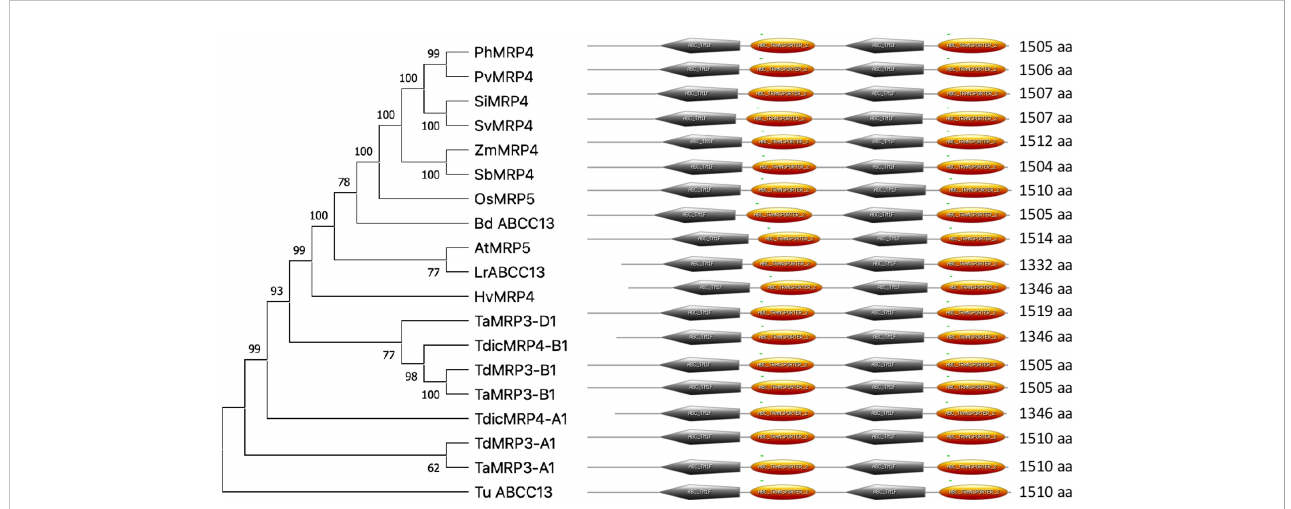
FIGURE 1 Phylogenetic tree of the ABCC multidrug resistance-associated protein (ABCC-MRP) in different plant species. Td: Triticum turgidum ssp durum MRP3- A1 (SVEVO PLATINUM SEQUENCE), MRP3-B (VEVO PLATINUM SEQUENCE), Ta: Triticum aestivum MRP3-A (XP_044384038 _TraesCS5A02G512500), MRP3-B (XP_044371728 TraesCS4B02G343800), MRP3-D (XP_044377018_TraesCS4D02G339000); Tu: Triticum urartu ABCC13 XP_048531007.1 ; Tdic: Triticum dicoc coides MRP4-A (XP_037437166.1), MRP4-B (XP_037426738.1); Hv: Hordeum vulgare MRP4 (XP 044983147.1); Bd: Brachypodium distachyon ABCC13 (XP_003558836.1); Zm: Zea mays MRP4 (EF586878); Sb: Sorghum bicolor MRP4 (XP 002468528.2); Pah: Panicum hallii MRP4 (XP 025794868.1); Pav: Panicum virgatum MRP4 (XP_039780041.1); Si: Setaria italica MRP4 (XP 004985744.1); Os: Oryza sativa Japonica group MRP5 (XP 015630971.1); At: Arabidopsis thaliana MRP5 (AT1G04120.1); Sv: Setaria viridis MRP4 (XP_034572896.1); Lr: Lolium rigidum ABCC13 like (XP_047089394.1). The tree constructed by the Neighbor-joining (NJ) method with pairwise deletion option and p-distance matrix in MEGA XI (Tamura et al., 2021). Bootstrap values (1000 replicates) were shown at each